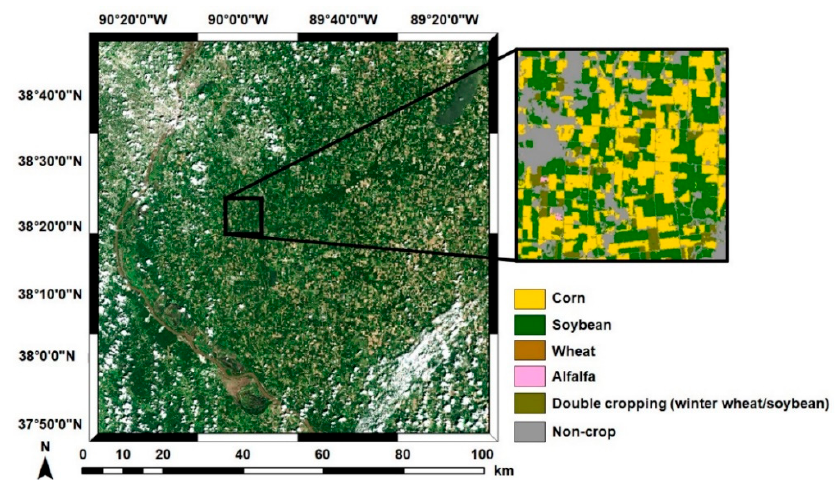
Figure 1. Location of the study area. The black box denotes the subarea where virtual image generation and crop classification are conducted. The background in the left image is the Sentinel-2 image on 30 July 2019, and the cropland data layer in 2019 in the study area is enlarged.